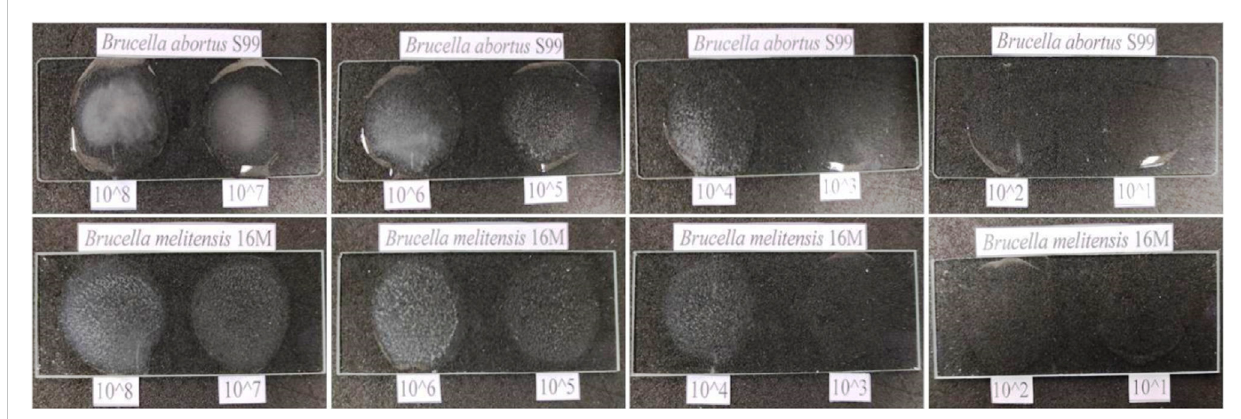
FIGURE 10 Rapiddirect-differentialslideagglutinationassaydeterminingalowerlimitofdetection(LOD)of10 4 CFU mL − 1 atanexperimentaldetectionrangeof